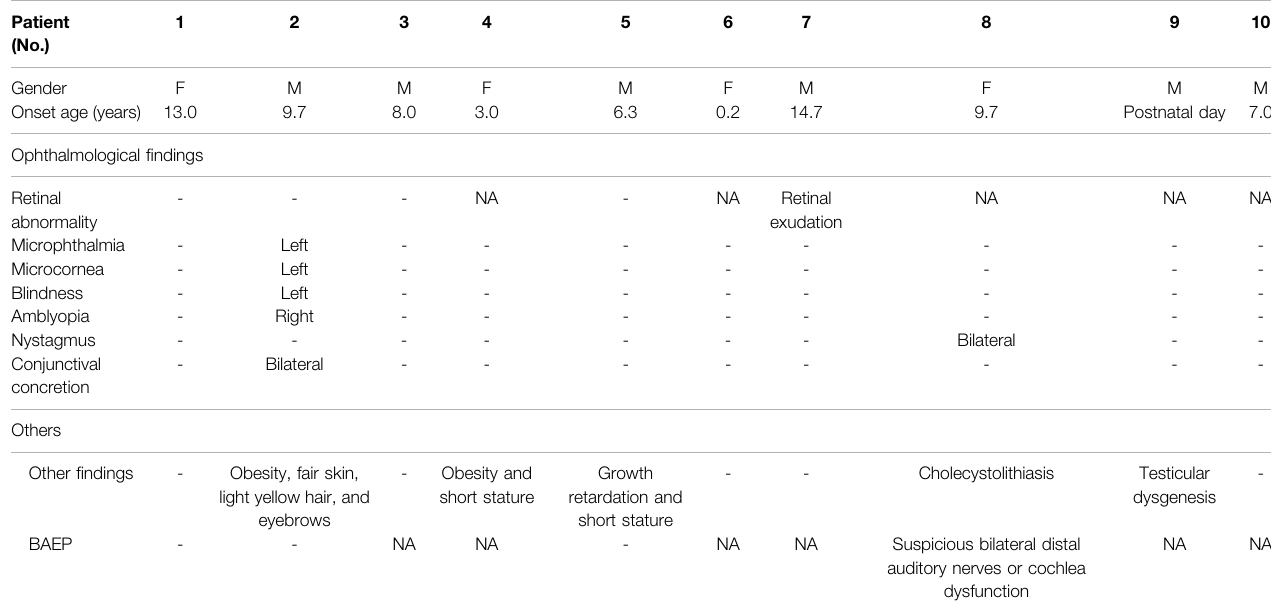
TABLE 2 | Extrarenal manifestations of patients with variants in PAX2 . Patient